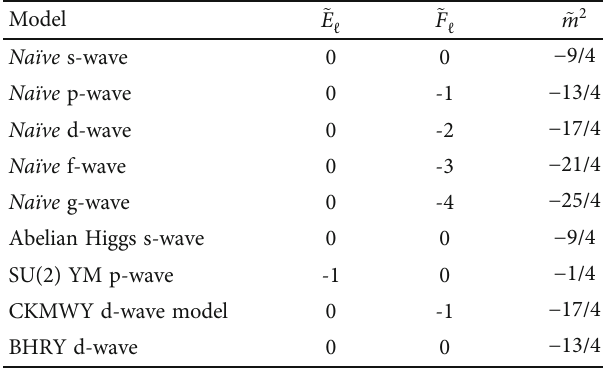
Table 3: Parameter choices for ~ m 2 at the BF